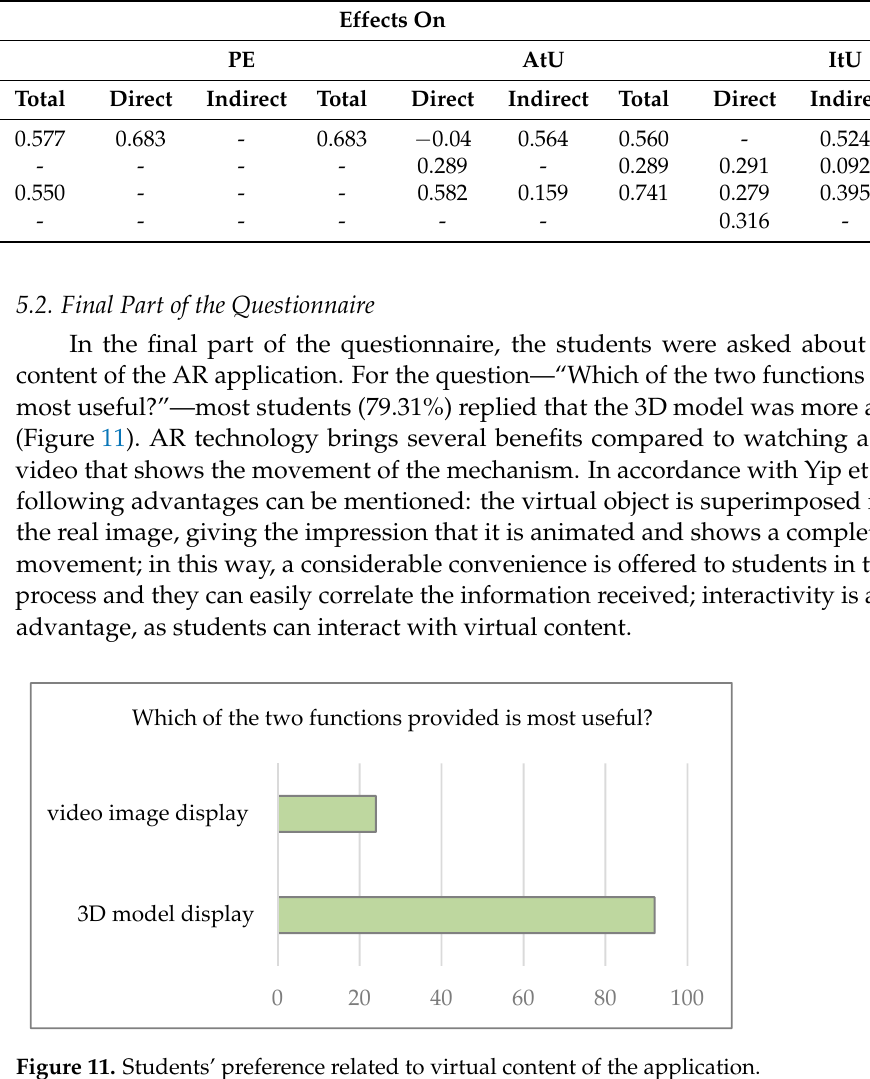
Figure 11. Students’ preference related to virtual content of the application.